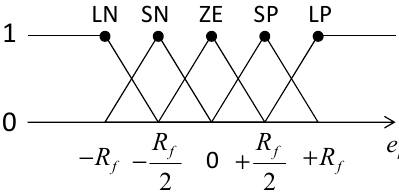
Figure 4. Membership function of fuzzifier (fuzzy set A).